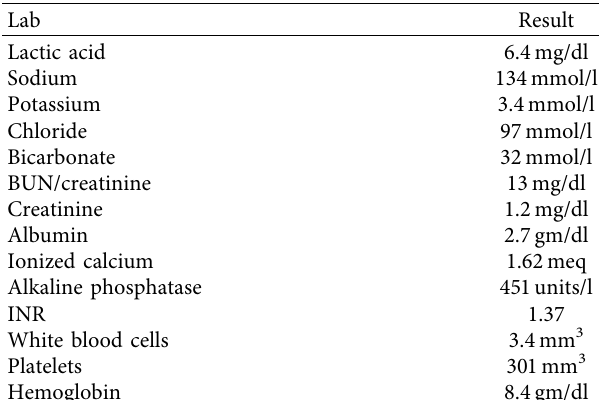
Table 1: Laboratory data.